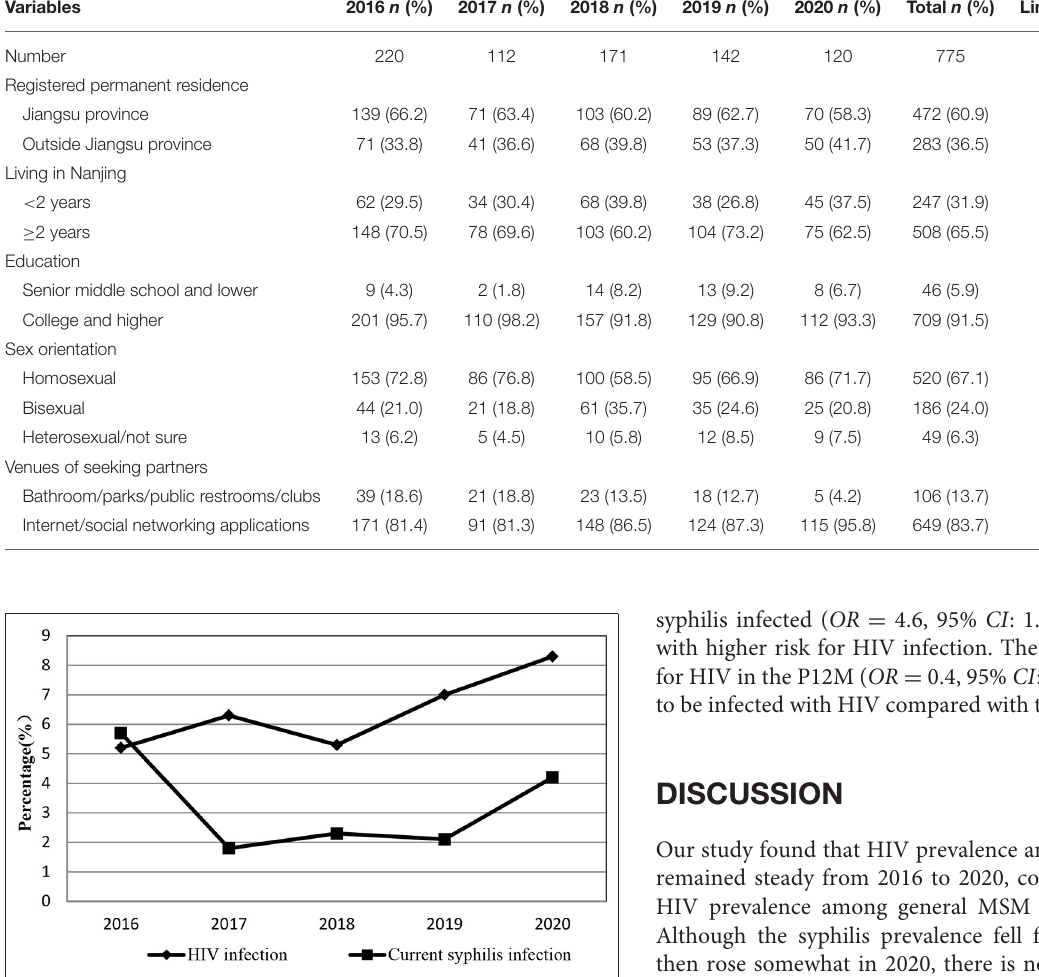
FIGURE 1 | The trend in the prevalence of HIV/Syphilis among SMSM in Nanjing, China,